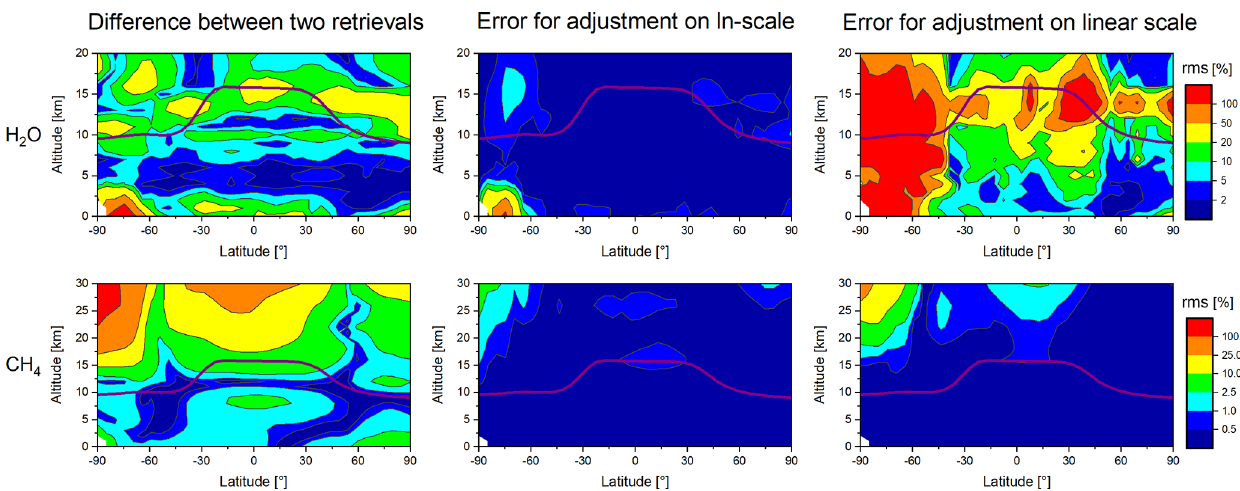
Figure B2. Results of the individually performed linearity tests for H 2 O and CH 4 . Shown are the following three latitudinal cross sections: (1) rms values between the original retrieval (retrieval results using the original a priori data) and the modified retrieval (retrieval results using the modified a priori data), (2) rms values between the modified retrieval and the original retrieval after performing the a posteriori adjustment according to Eq. (B1) on a logarithmic scale, and (3) same as (2) but for the a posteriori adjustment performed on a linear scale. The thick solid violet line indicates the tropopause